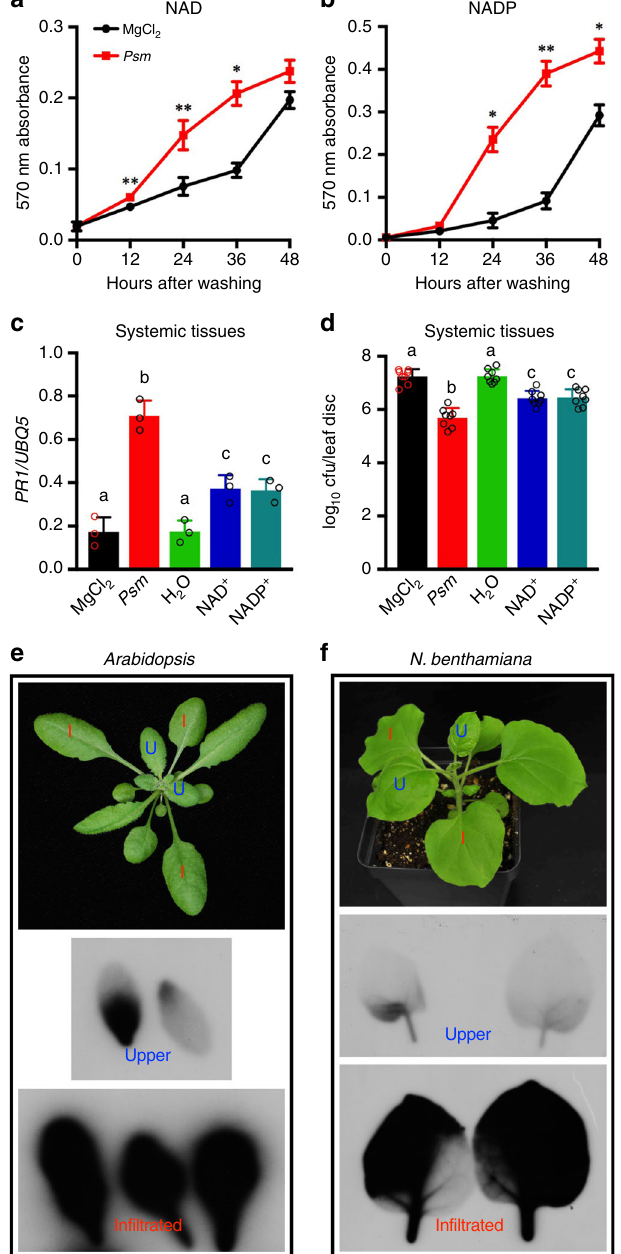
intensity of the potential 32 P-NAD + band in the extract of 35 S: CD38 systemic leaves was signi fi cantly reduced (Supplementary Fig. 2b), indicating that the movement of 32 P-NAD + in the 35 S: CD38 plants was inhibited. This observation is line with the previously reported result that SAR induction is partially compromised in 35 S:CD38 plants 21 .